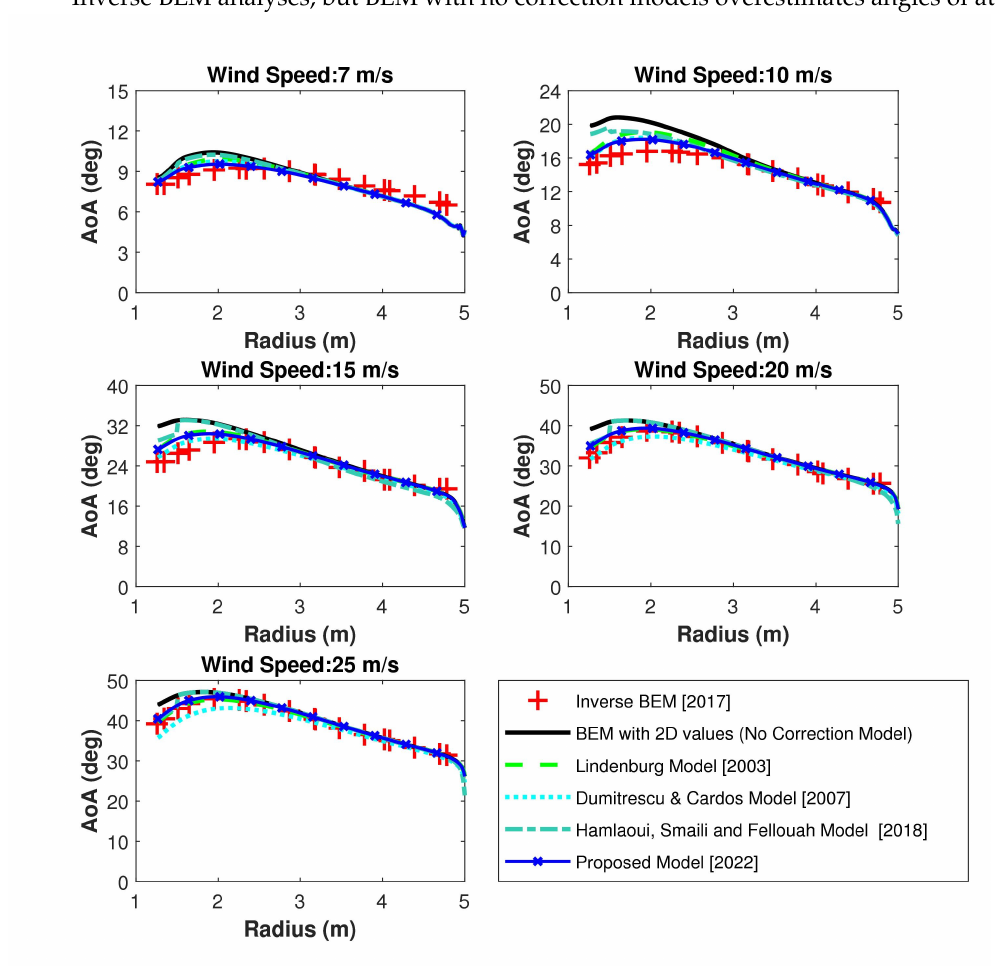
Figure 6. Contrast of evaluated AoA throughout the blade length from BEM analysis without and with different correction models for stall delay and Inverse BEM method for NREL Phase VI